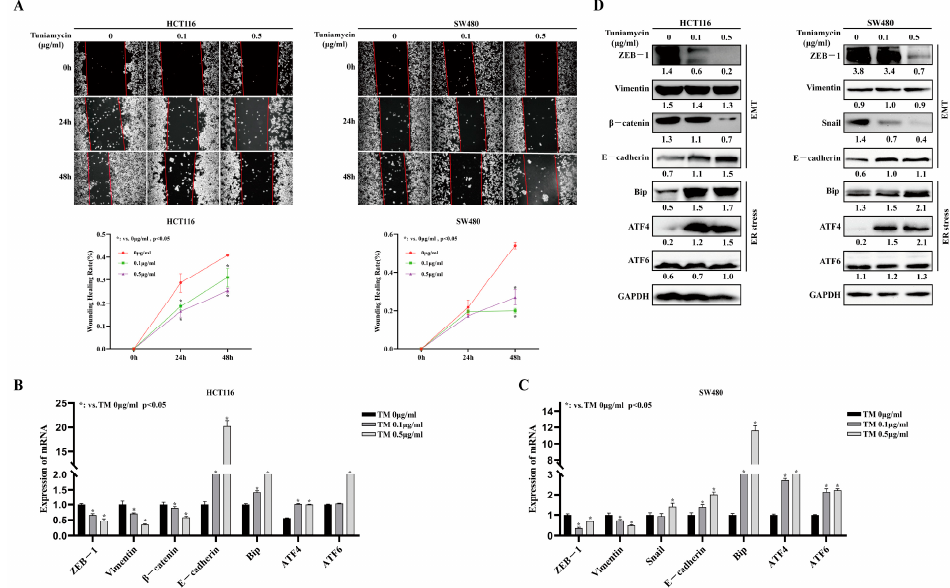
Figure 3. Tunicamycin inhibits epithelial-to-mesenchymal transition in human CRC cell lines. SW480 and HCT116 cells were exposed to tunicamycin (0.1 μ g/mL, 0.5 μ g/mL). ( A ) Wound healing test revealed that tunicamycin inhibited HCT116 and SW480 cell migration. ( B – D ) SW480 and HCT116 cells were exposed to tunicamycin (0.1 μ g/mL, 0.5 μ g/mL) for 6 h, and then analyzed for protein and mRNA expression. qRT-PCR and Western blotting results showed the expression of proteins and mRNA involved in EMT.